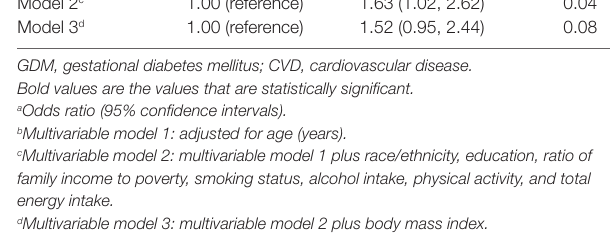
Women Women with without history of gDM history of gDM